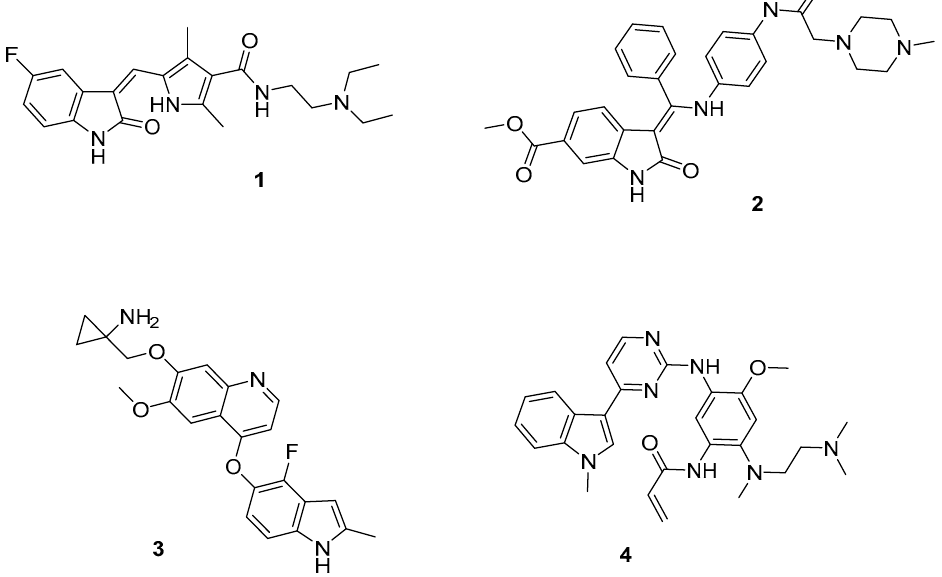
Chart 1. Indole-based PDGFR/VEGFR inhibitors ( 1 – 3 ) and EGFR inhibitor ( 4